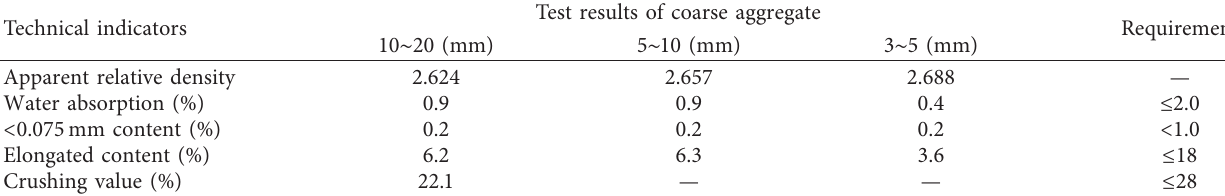
Table 2: Technical indicators of coarse aggregates.